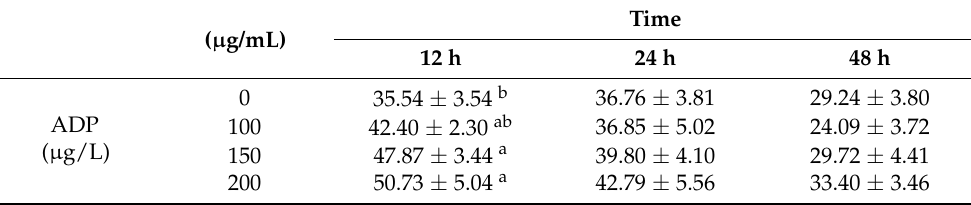
Table 5. Effect of different concentrations of GSP on ADP levels in mature adipocytes.